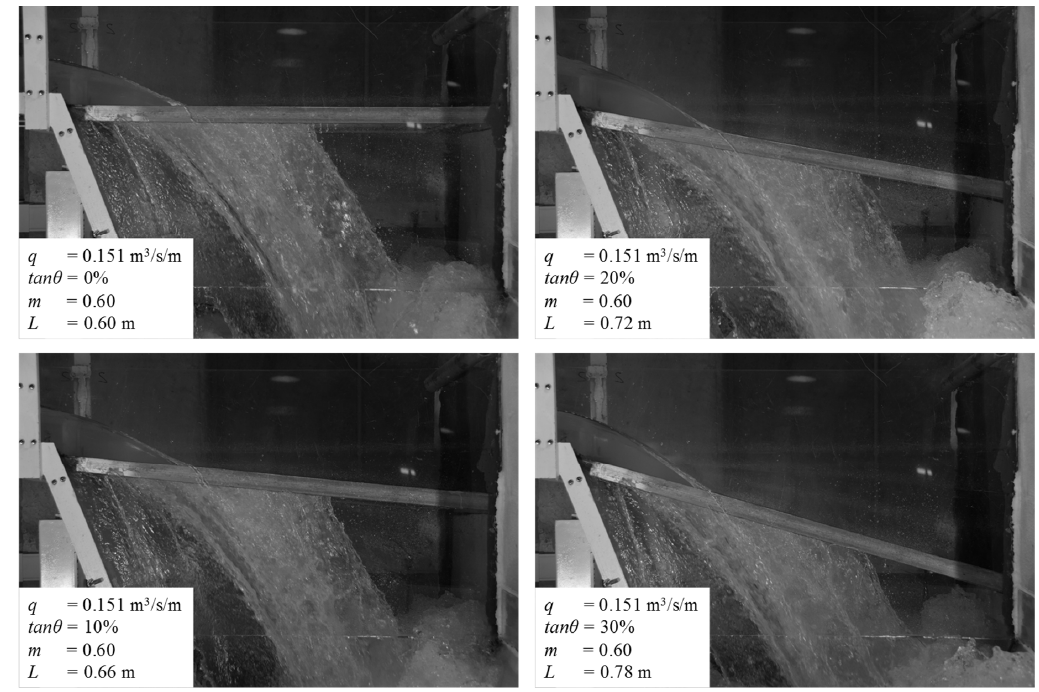
Figure 3. Wetted rack length for different flows and longitudinal slopes with racks made of circular bars and void ratio m = 0.28.